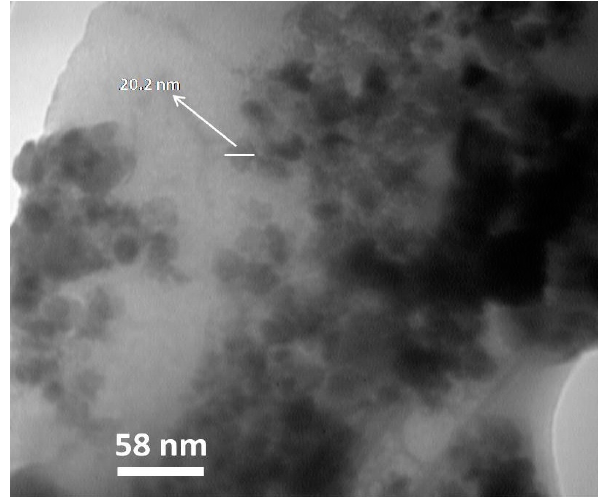
Figure 6. TEM image of fresh GO/Fe 3 O 4 / L -pro nano hybrid.